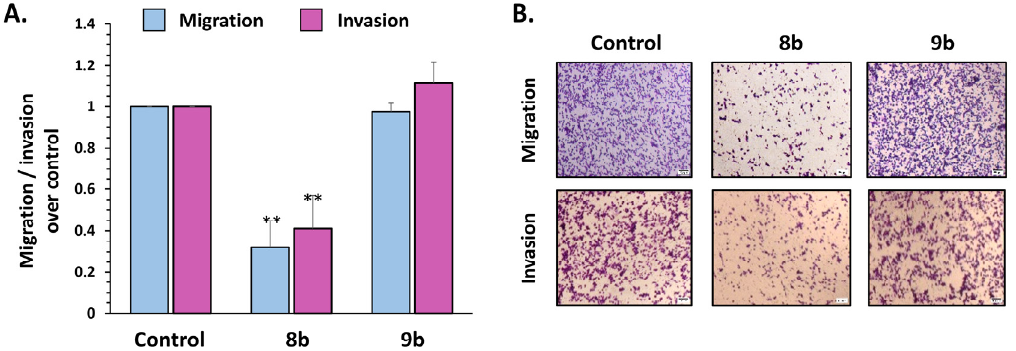
Figure 7. Compound 8b inhibits migration and invasion of MDA-MB-231 cells ( A ). MDA-MB-231 cells were subjected to bicameral migration (blue) and invasion (purple) assay. Cells were treated with 5 µM of 8b and 10 µM of 9b for 24 h. Cells in the bottom of the 8 mm pore membrane were fixed and quantified. Microphotographs show crystal-violet-stained migratory and invasive cells ( B ). Magnification 40×, scale bar = 50 µm. Representative results from three independent experiments are shown. Significant difference between treatments was determined by t -test: ** p < 0.01.